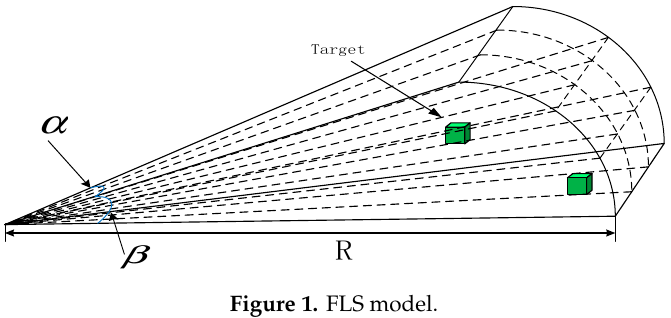
Figure 1. FLS Figure 1. FLS model.